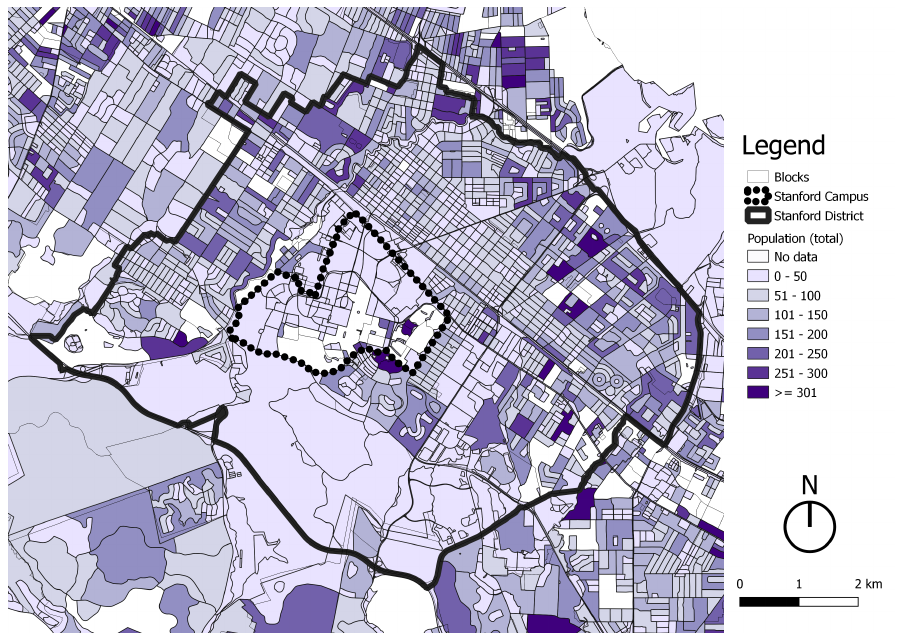
Figure 4. Population by block in Stanford District, San Francisco Bay